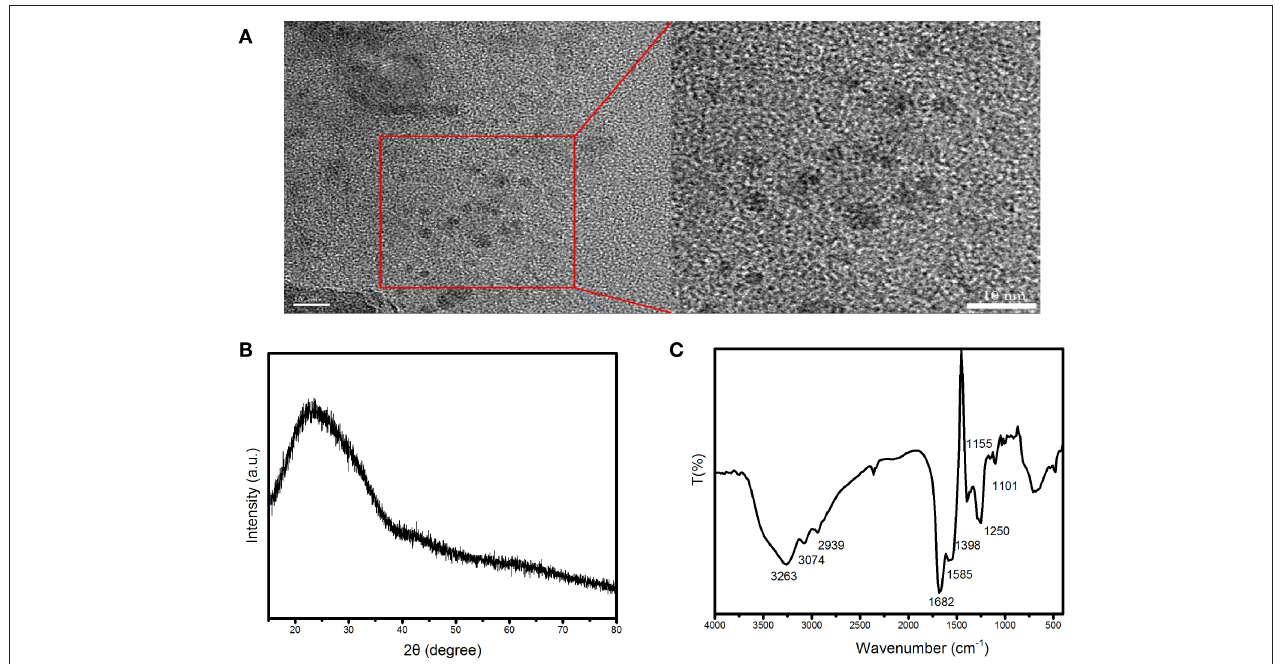
FIGURE 1 | (A) TEM image, (B) XRD pattern, and (C) FTIR spectrum of the as-synthesized carbon dots.